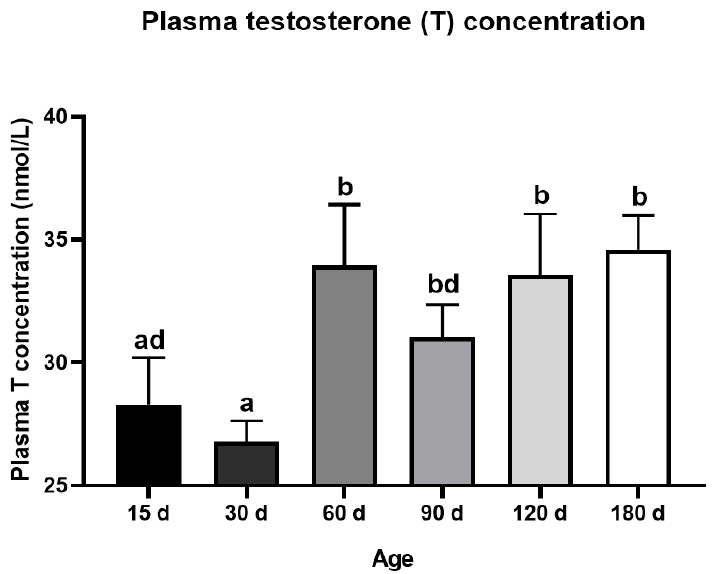
Figure 2. Dynamic changes of plasma testosterone level during postnatal development of the Congjiang Xiang pig. The blood was collected from the jugular vein by a board-certified veterinarian. Congjiang Xiang pig. The blood was collected from the jugular vein by a board ‐ certified veterinar ‐ ian. Results are indicated by means ± SD (n ≥ 3). The data was analyzed by one ‐ way ANOVA with Results are indicated by means ± SD ( n ≥ 3). The data was analyzed by one-way ANOVA with Tukey’s multiple comparisons. Values not sharing the same letter (a–d) denote significant differ ‐ Tukey’s multiple comparisons. Values not sharing the same letter (a,b,d) denote significant ences among groups ( p < 0.05).